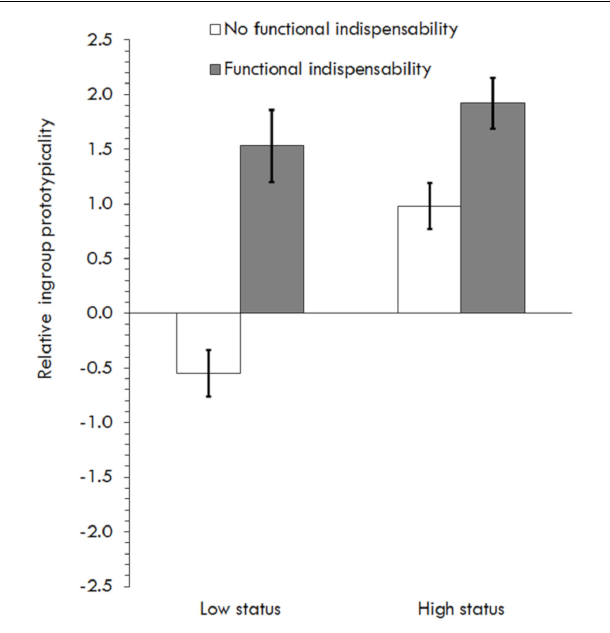
FIGURE 4 | Effects of relative ingroup prototypicality depending on functional indispensability and status in Study